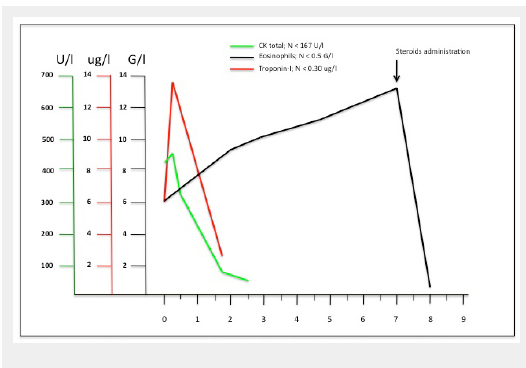
Representation of cardiac enzymes and eosinophils count evolution between the arrive in the emergency unit and the day after corticosteroid